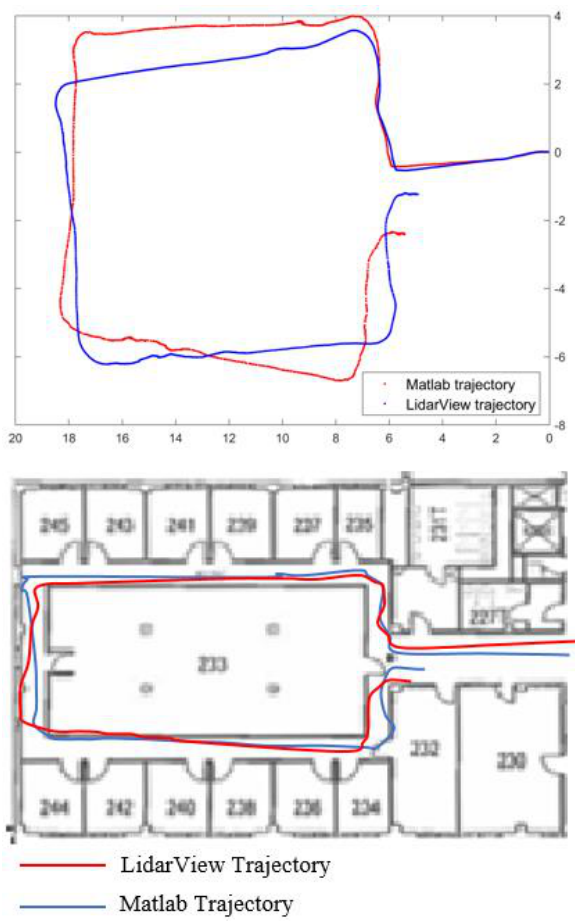
Figure 5 . Trajectory for C-D-E-F-G corridor section, Blue line: Matlab trajectory, Red Line: LidarView (Top View), Trajectory data matched with the underlying floor plan (Bottom View) Trajectory (m) Table 3. Trajectory lengths obtained from both software for C- D-E-F corridor segment